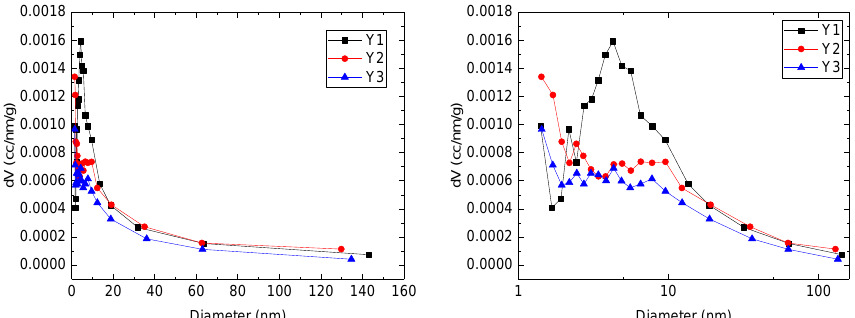
Figure 5. Pore size distribution curves derived by Nitrogen adsorption-desorption tests.